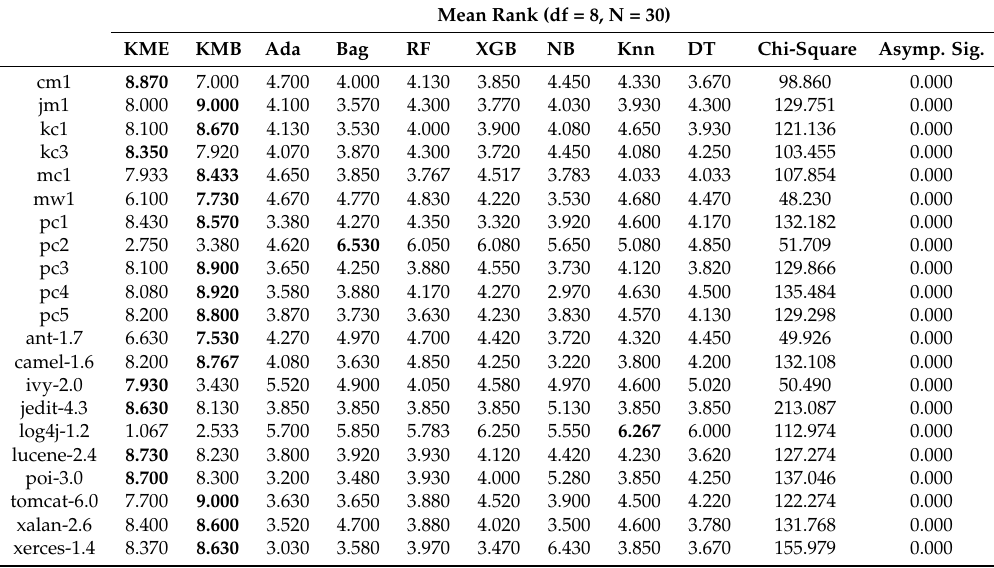
Table 9. Friedman test